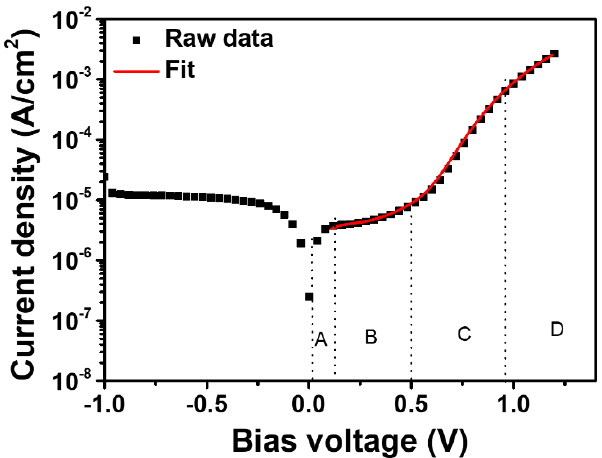
Figure 9. Plots of the dark current for a pure PbI 2 solar cell as well as the fitting curve by using Equation (3). The inset regions A, B, C, and D are mainly determined by ohmic current, shunt plus capacitive current, recombination plus diffusion current in the diode region, and diode current limited by series resistance, respectively.